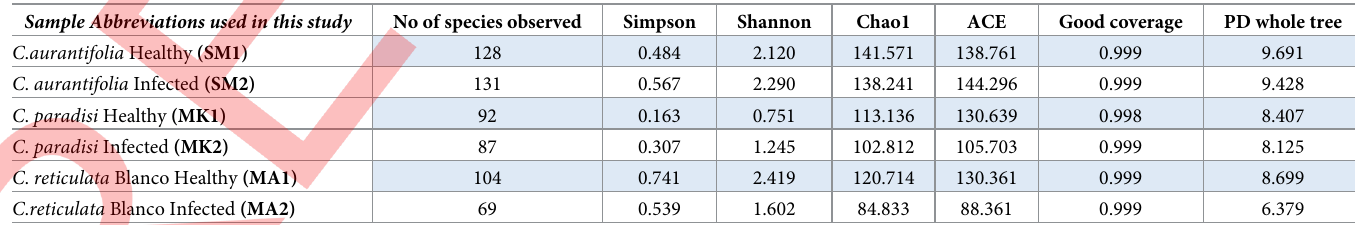
Table 2. Statistical analysis of alpha diversity (AD) indices from NGS data of citrus leaves. Sample Abbreviations used in this